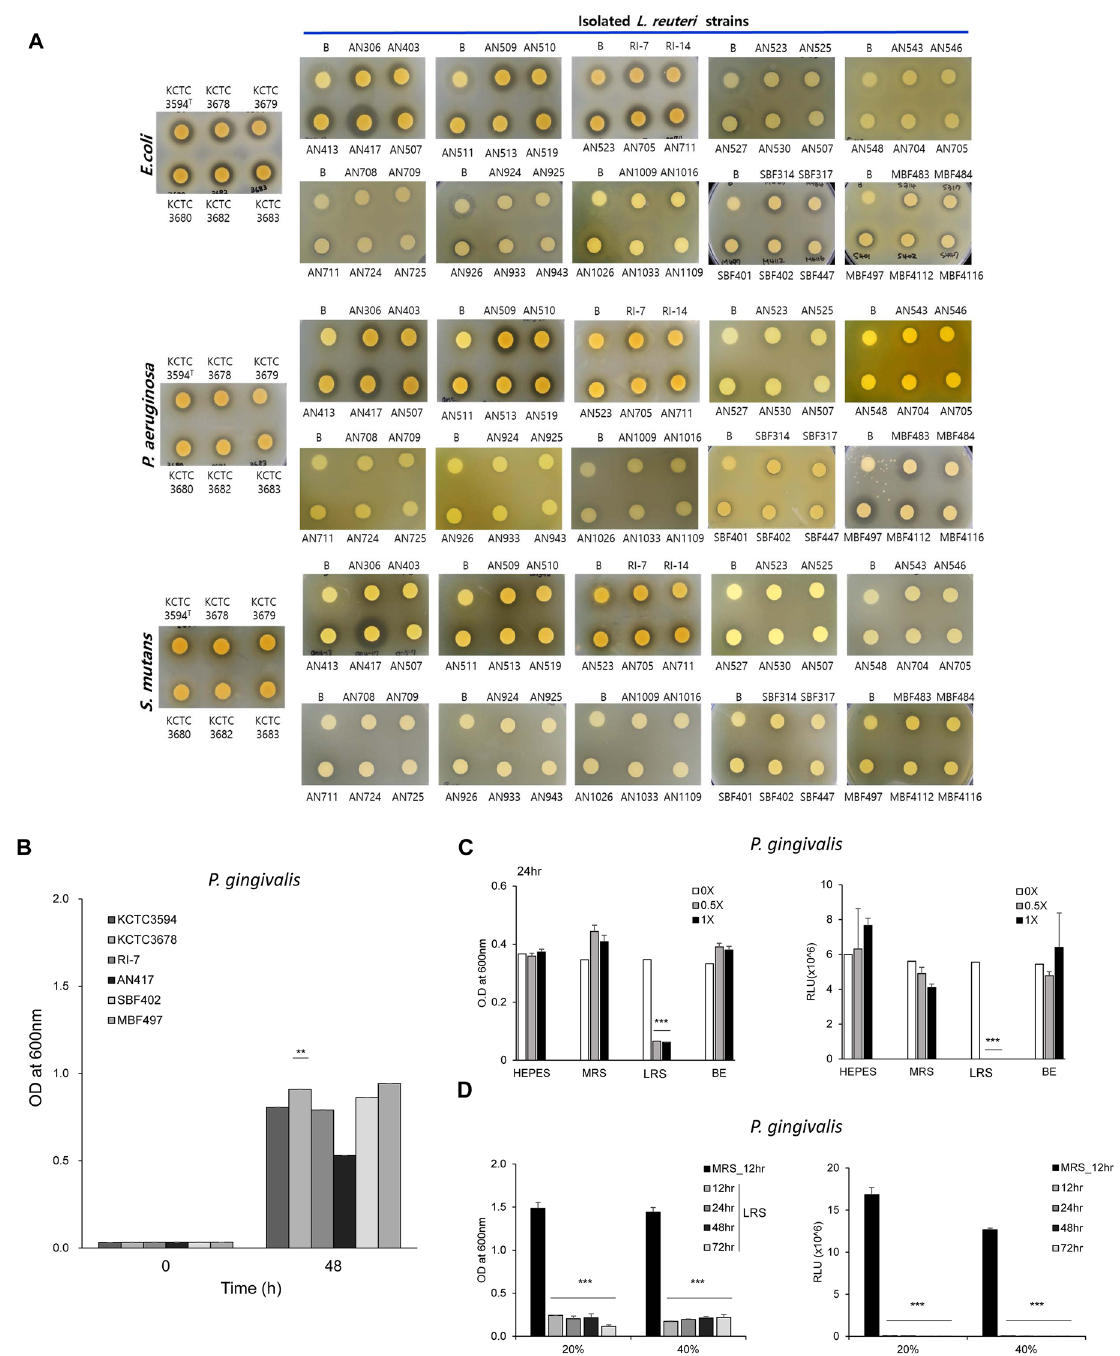
Figure 1. Evaluation of the antimicrobial activity of culture supernatants of L. reuteri strains against E. coli, P. aeruginosa, S. mutans , and P. gingivalis. ( A ) The antimicrobial activity of culture supernatants from newly isolated and reference L. reuteri strains against E. coli, P. aeruginosa and S. mutans was analyzed through disk diffusion assays following 24 h incubation at 37 °C. ( B ) Growth curve of P. gingivalis at OD 600 measured using a disposable curvet 48 h after treatment with the supernatants of each strains. Significant differences from the control ( p < 0.01) are indicated by **. ( C ) The effect of various concentrations of LRS and BE on P. gingivalis growth, measured by OD 600 (left panel) and intracellular ATP levels (right panel) following a 24 h incubation at 37 °C. MRS medium was used as the negative control. Significant differences from the control ( p < 0.001) are indicated by ***. ( D ) The effect of 20% (v/v) and 40% (v/v) LRS on P. gingivalis growth (left panel) and intracellular ATP levels (right panel) over time. MRS medium was used as the negative control. Significant differences from the control ( p < 0.001) are indicated by